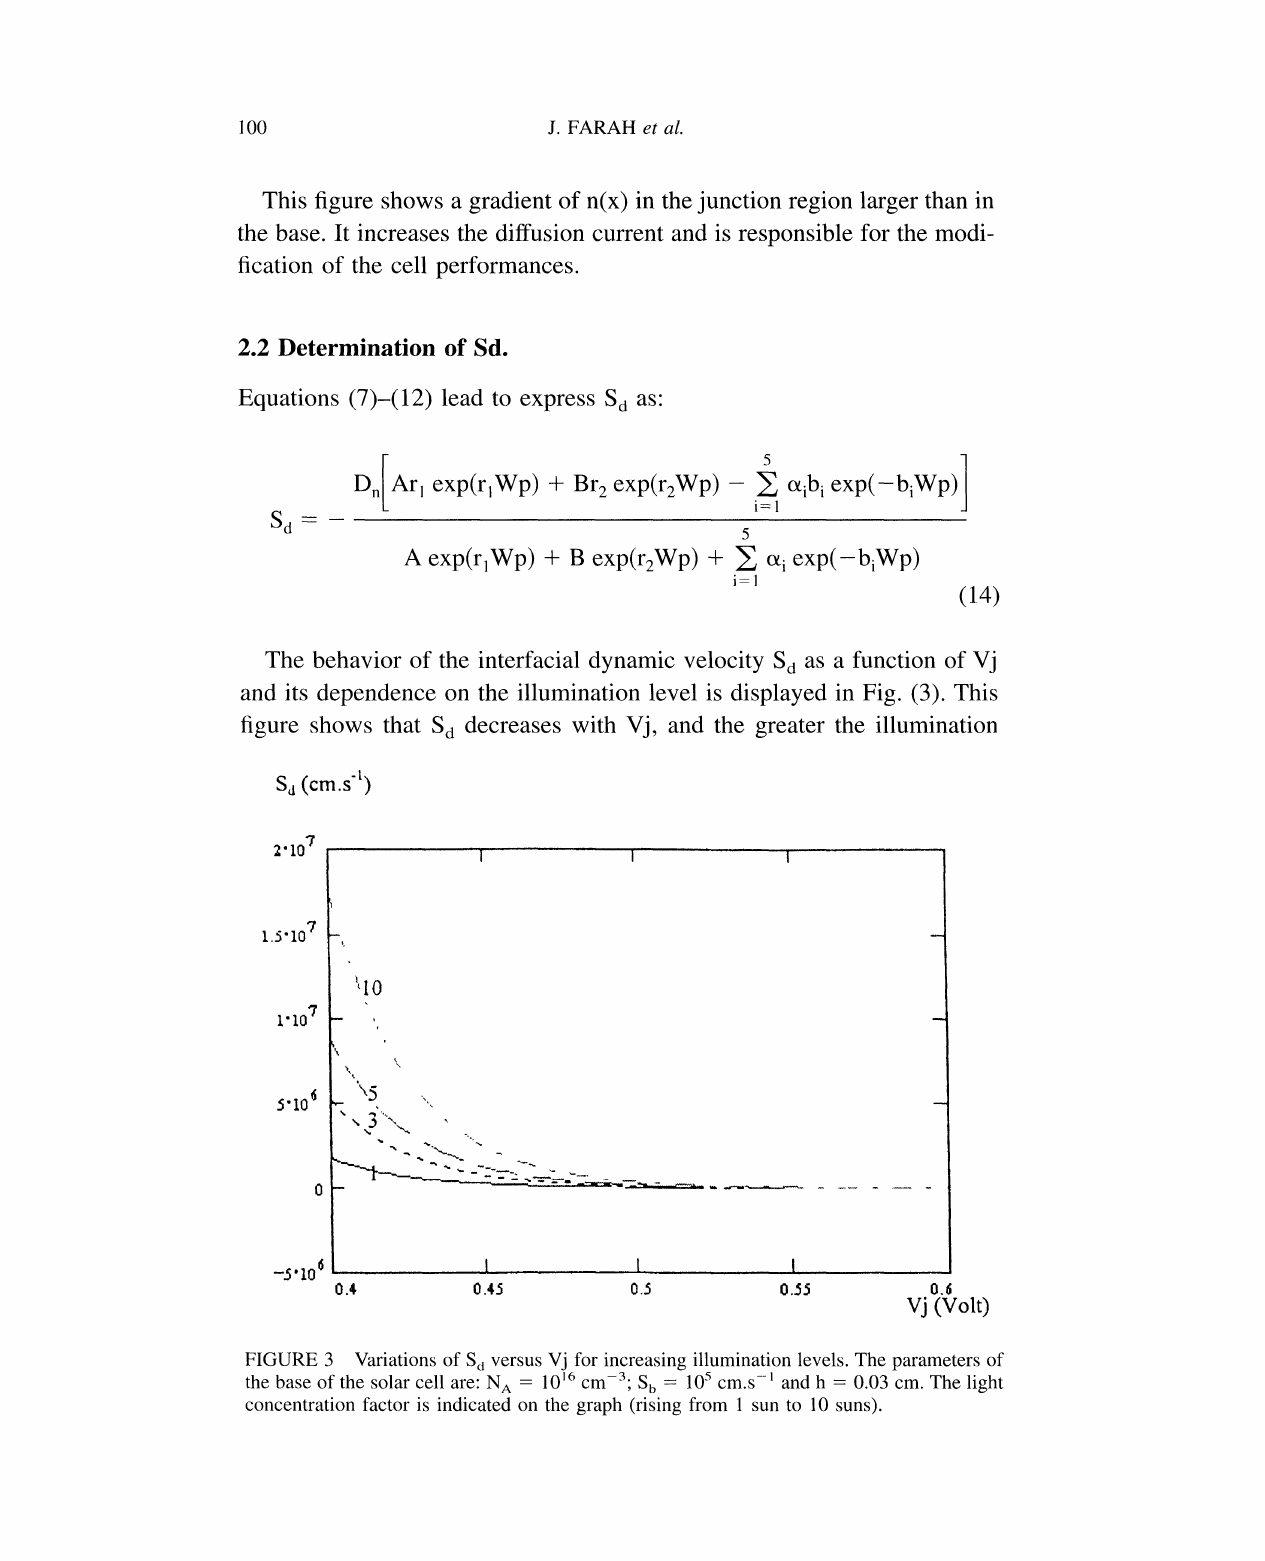
FIGURE 3 Variations of S versus Vj for increasing illumination levels. The parameters of the base of the solar cell are: N A 1016 cm-3; S 105 cm.s -1 and h 0.03 cm. The light concentration factor is indicated on the graph (rising from sun to 10